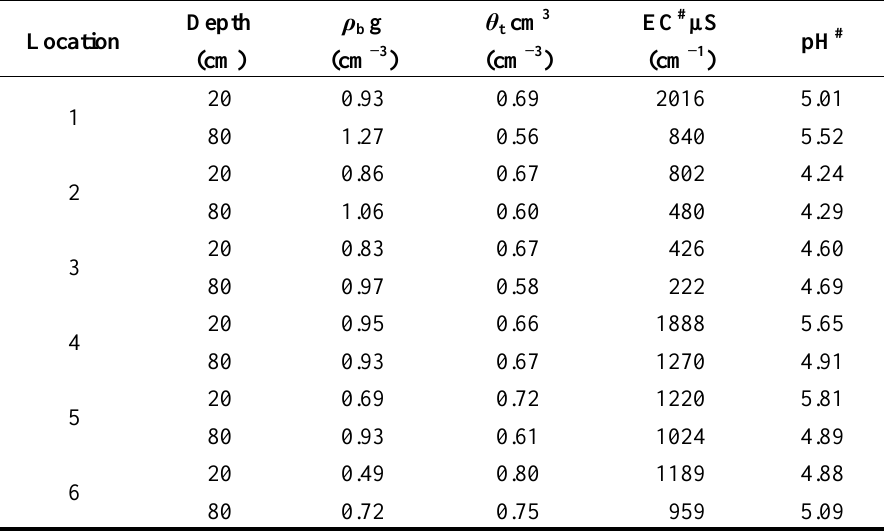
Table 3. Measured soil bulk density ( ρ and pH of the soil samples collected from 20 and 80 cm depths at the six monitoring locations in the upper Mākaha Valley sub-watershed.